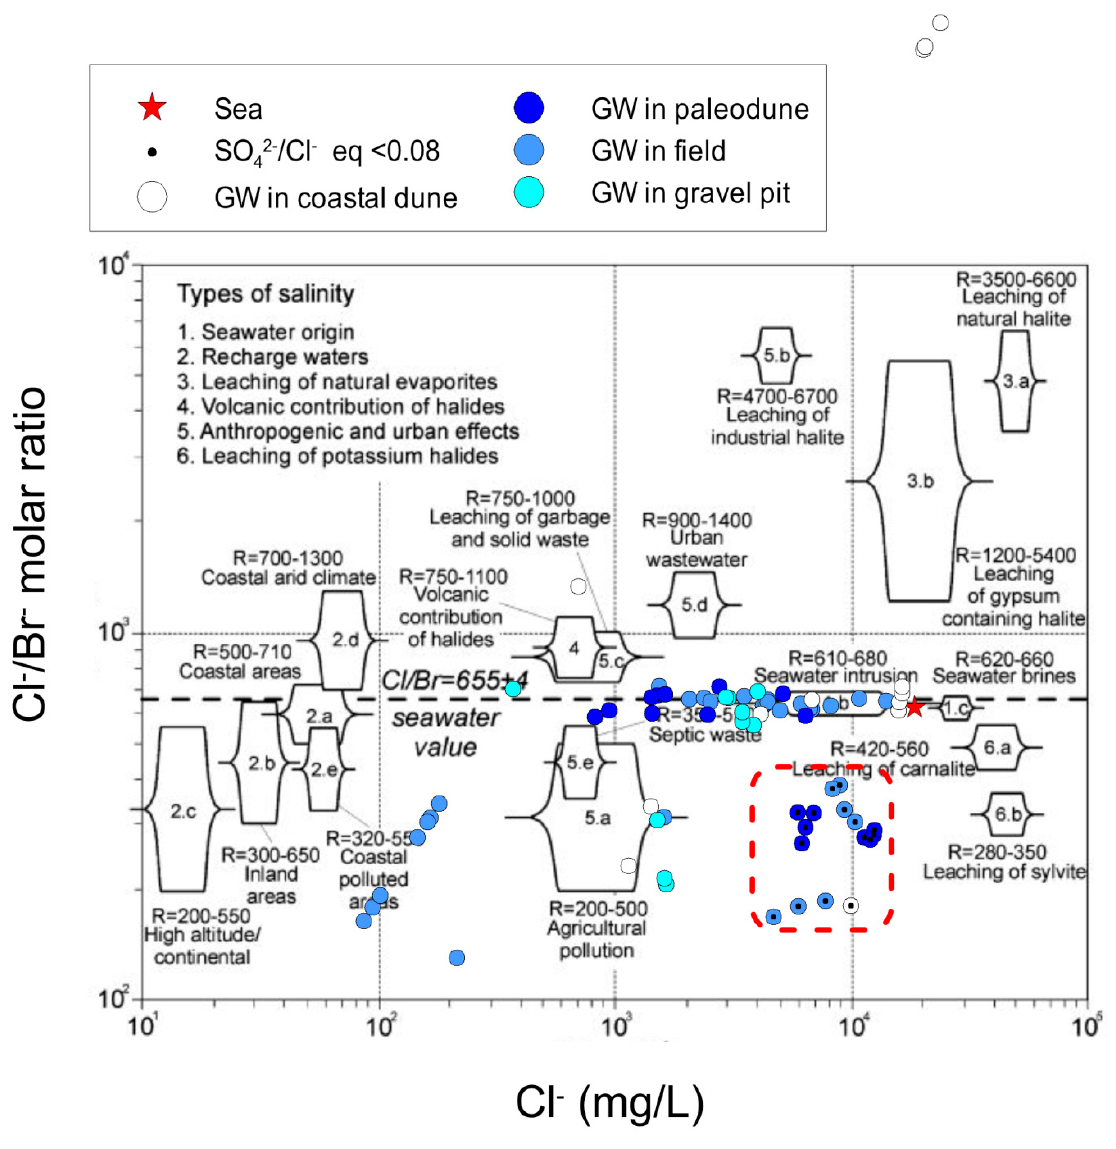
Figure 6. Diagram of Cl − /Br − molar ratio vs Cl − (mg/L) for all groundwater samples. Black and white background image is the diagram of Cl − /Br − molar ratio vs Cl − (mg/L) proposed by Alcalá and Custodio [22] to identify the salinity’s origin. The red box is enlarged in Figure S3 to label each sample.